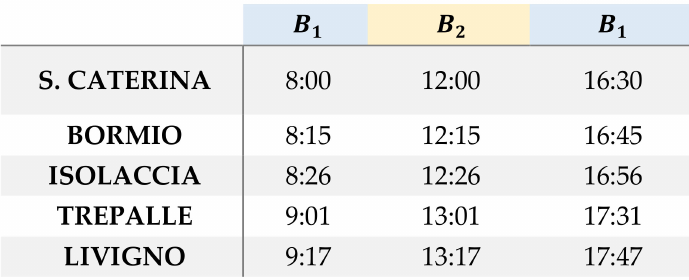
Figure 14. Low season